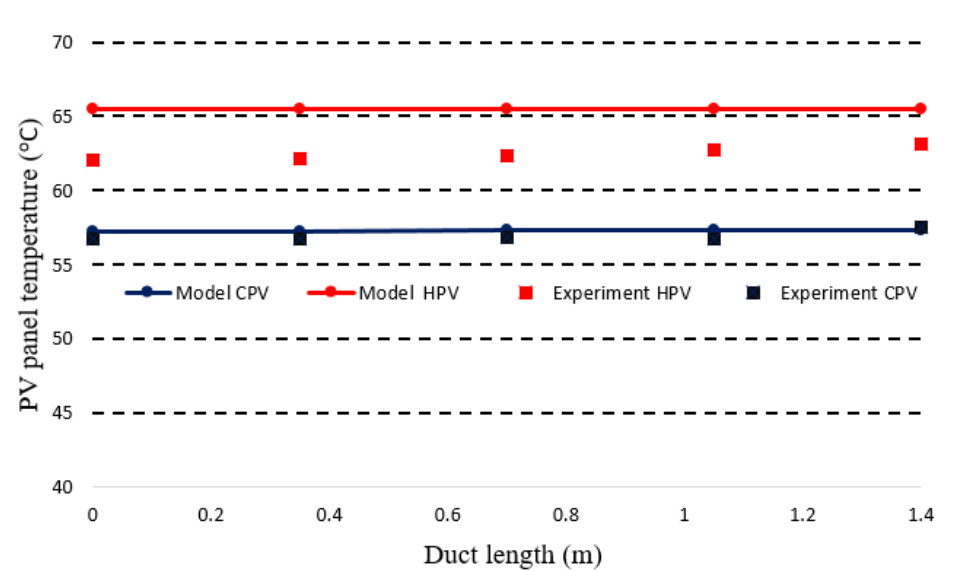
Figure 10. Experimental and simulated cooled and reference PV temperatures on 20 June at 11:05.